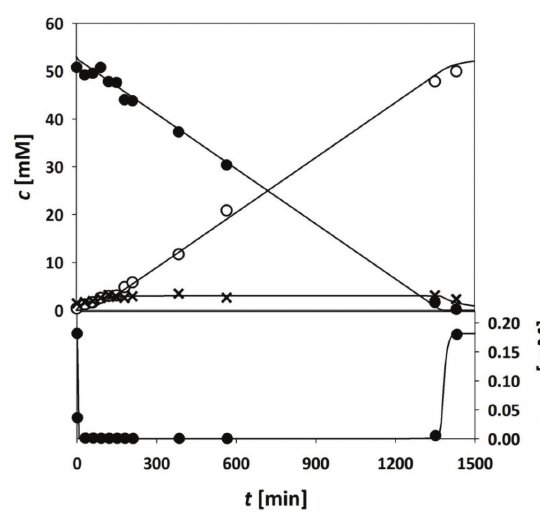
Fig. 5 – Glucose oxidation catalysed by free GOD from As- pergillus niger in the batch reactor (c = 50 mM, γ = glucose0 free GOD 0.04 mg cm –3 , φ = 0.002, 0.1 M phosphate buffer pH = 7; catalase 30 °C; V = 50 cm 3 ) without aeration (upper graph: black reactor circle – glucose, white circles –gluconic acid, x – glucono-δ-lac- tone; bottom graph – oxygen).